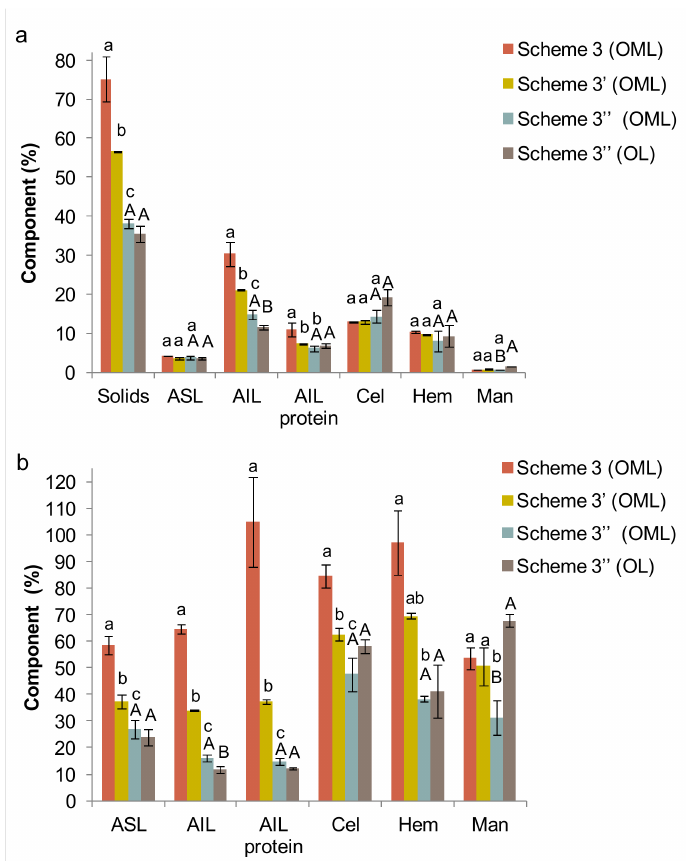
Figure 5. ( a ) Yield of solids (%) and content (%) of acid-soluble lignin (ASL), acid-insoluble lignin (AIL), protein in AIL, cellulose (Cel) and hemicellulose (Hem) and mannitol (Man) in the remaining fraction from olive mill leaves (OML) and olive leaves (OL) after phenolic extraction followed by alkaline extraction using NaOH 0.03 M, 60 ◦ C, 125 min (Scheme 3), NaOH 0.4 M, 80 ◦ C, 4 h (Scheme 3 (cid:48) ), and NaOH 0.7 M, 100 ◦ C, 4 h (Scheme 3 (cid:48)(cid:48) , optimum conditions). ( b ) Corresponding recovery values (%) with respect to the initial amounts in both